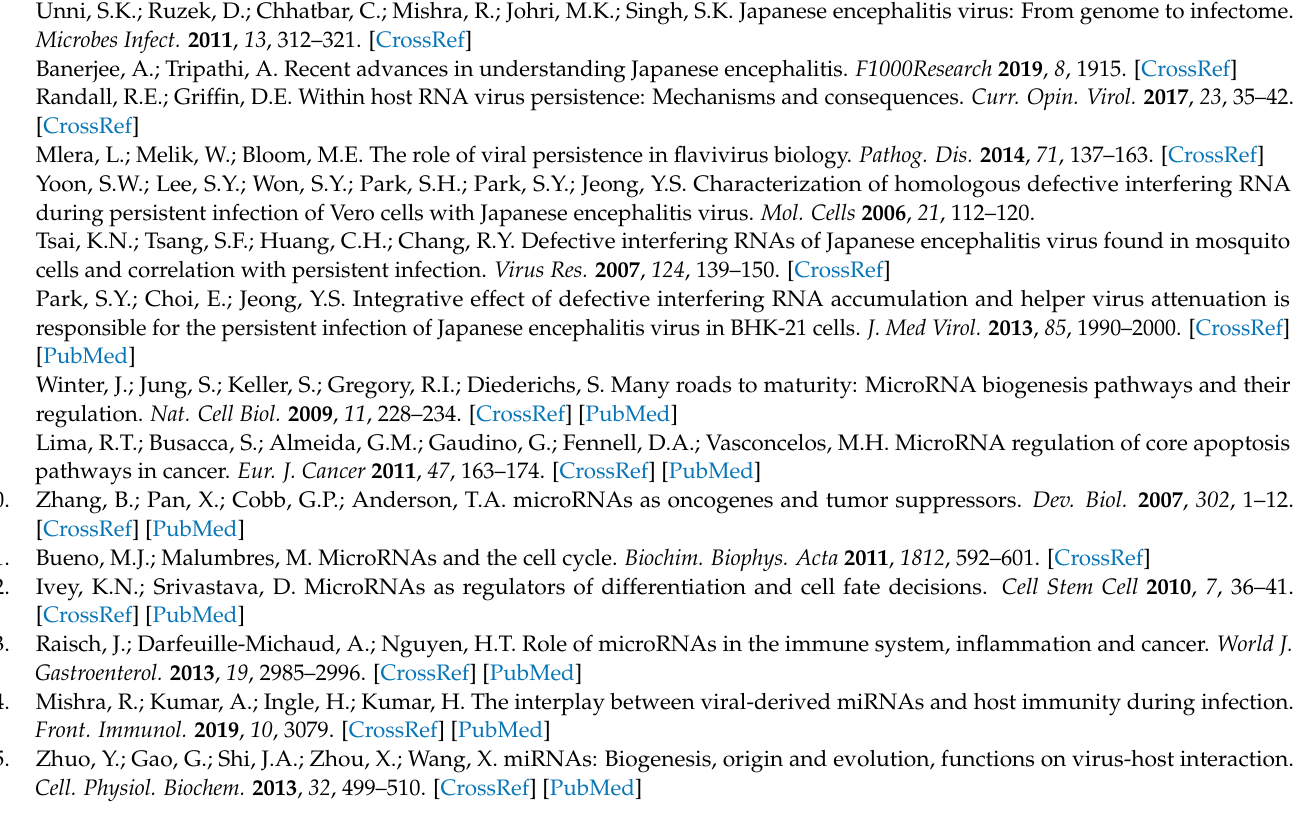
study, Table S2: Oligonucleotides used in this study, Table S3: Plasmid DNA used in this